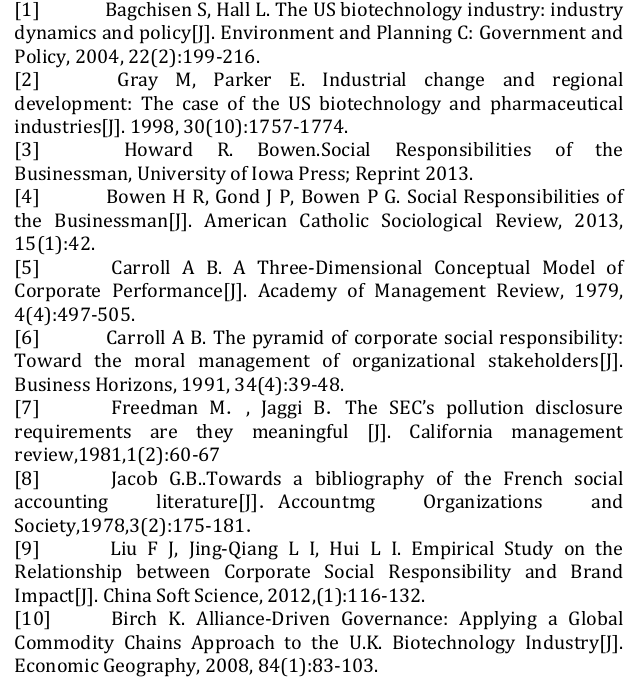
Table 3 factor analysis score F2005